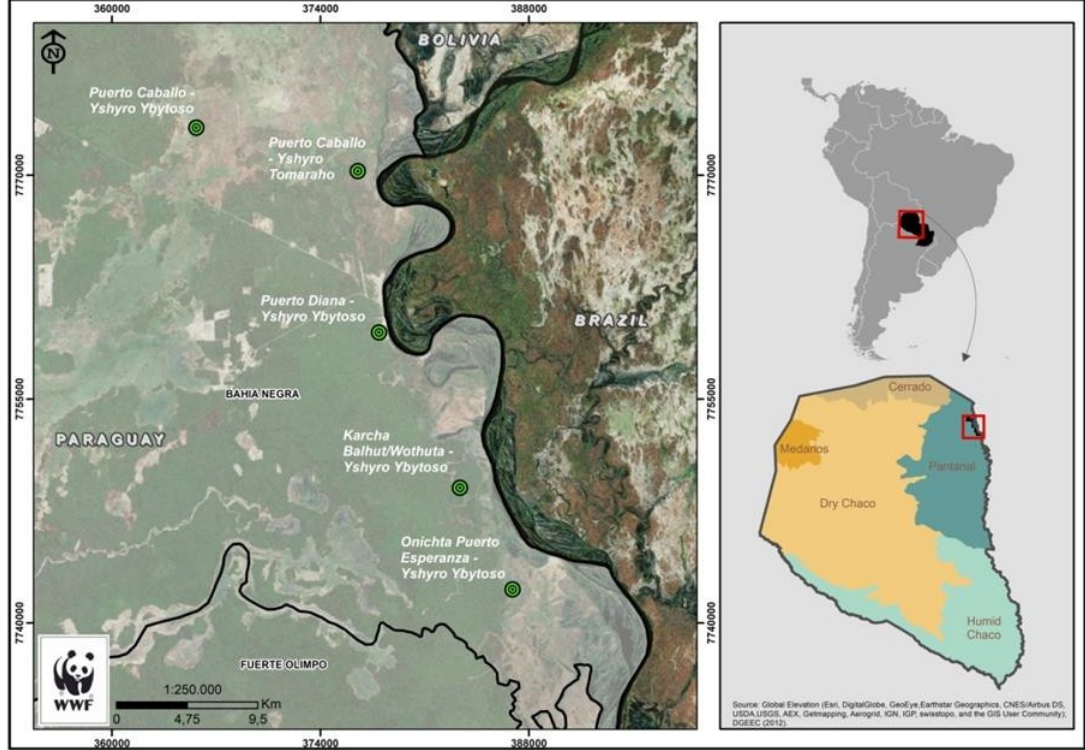
Figure 4. The Paraguayan Pantanal. Source: Global Elevation (Esri, DigitalGlobe, GeoEye, Earthstar Geographics, the French Space Agency (CNES)/Airbus Defense and Space, the U.S. Geological Survey (USGS), Adapter Engine Extended (AEX), Getmapping, Aerogrid, Institut Geographique National (IGN), Zonificación Sísmica–Geotécnica (IGP), swisstopo, and the Geographic Information Systems (GIS) User Community); Dirección General de Estadística, Encuestas y Censos (DGEEC) (2015).